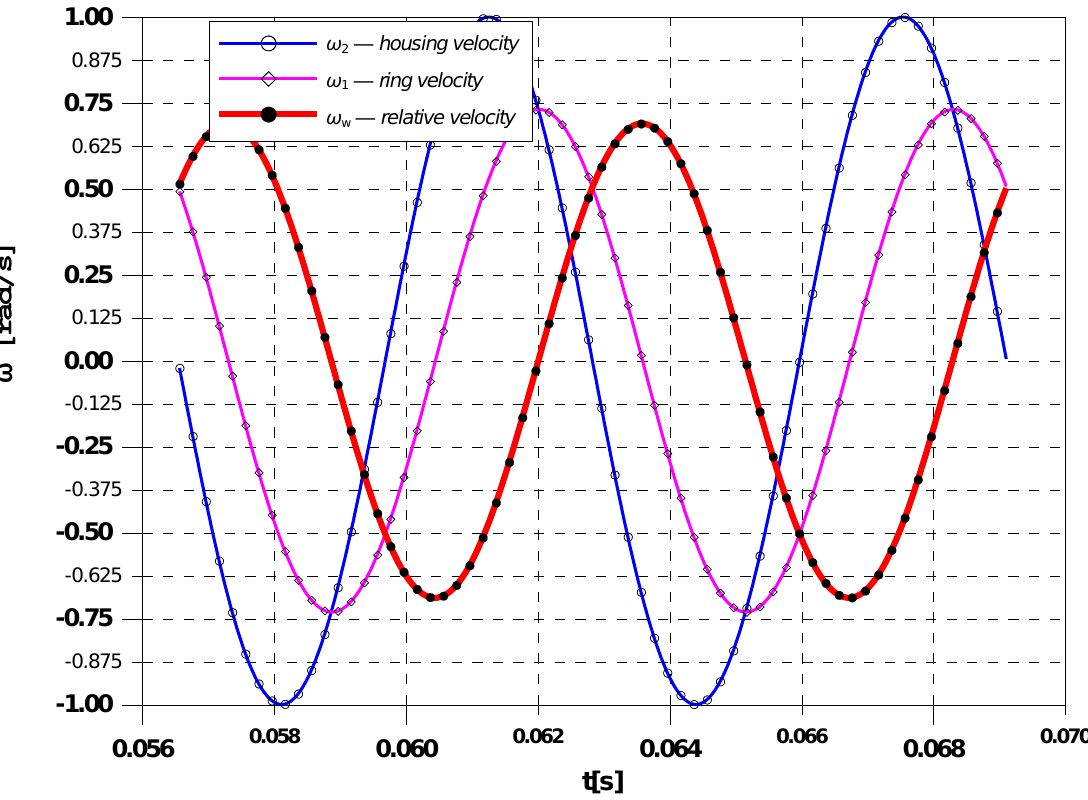
Figure 7. Angular velocity charts: ω 2 —of the housing, ω 1 —of the ring, ω w —of relative angular velocity [8]. In the initial period of operation of the damper, the heat generated in it heats up the